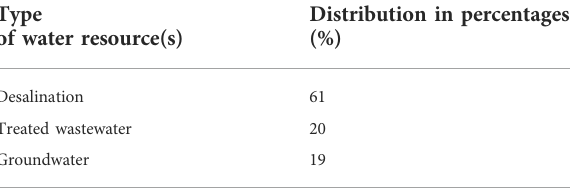
TABLE 1 Water resources distribution in Kuwait (World Bank,